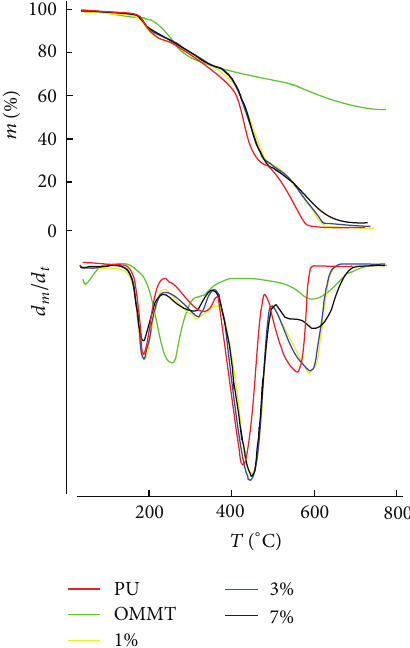
Figure 7: TGA and DTG thermograms of PU, OMMT, and PU/OMMT nanocomposites.